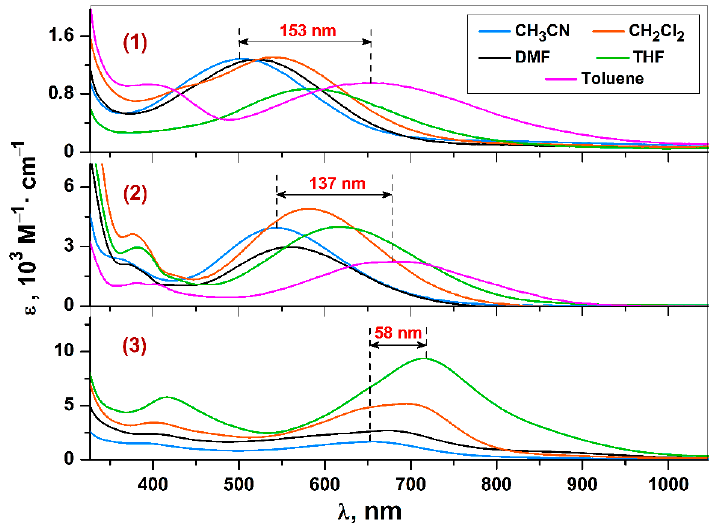
Figure 7. UV-vis-NIR spectra for complexes 1 – 3